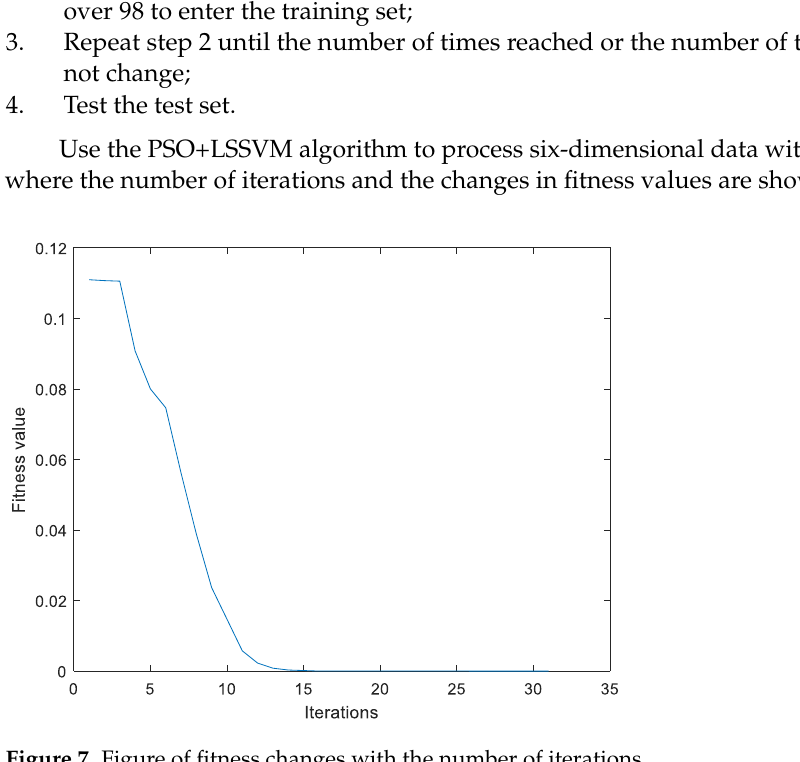
Figure 7. Figure of fitness changes with the number of iterations. The convergence speed is accelerated after 7 iterations, and the model has basically converged when it reaches 25 iterations. The PSO+LSSVM algorithm has faster convergence speed than the LSSVM algorithm alone, and the optimal solution can be found